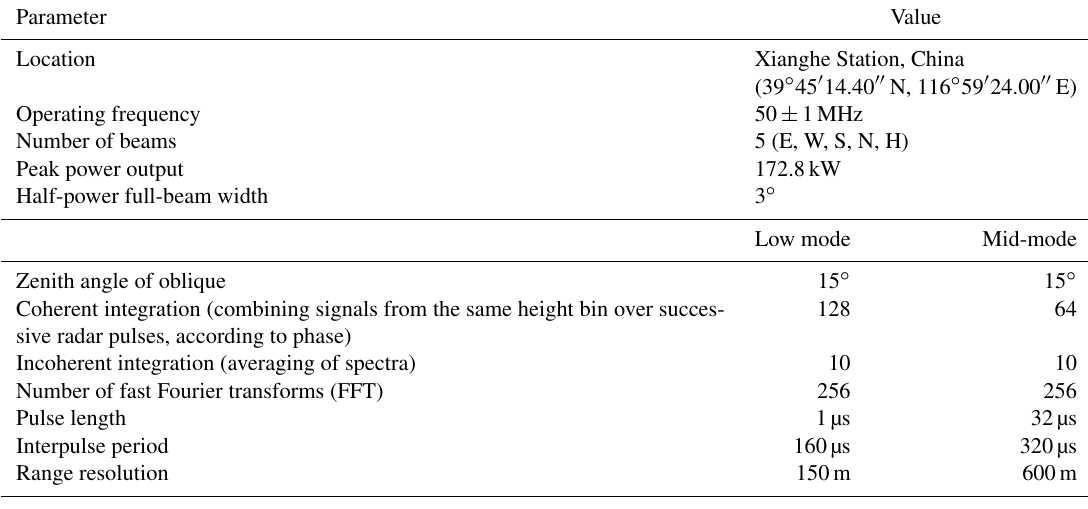
Table 1. Parameters of the Beijing MST radar.